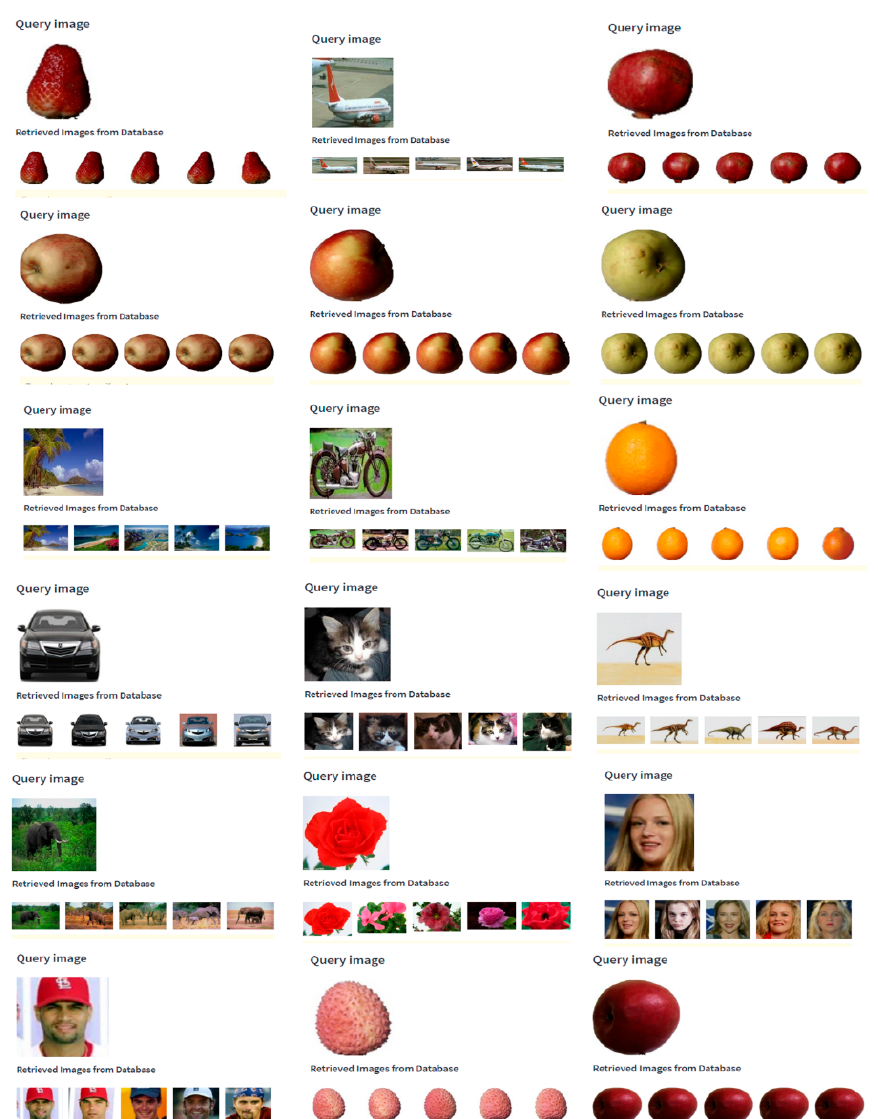
Figure 6. Samples results of CBIR.